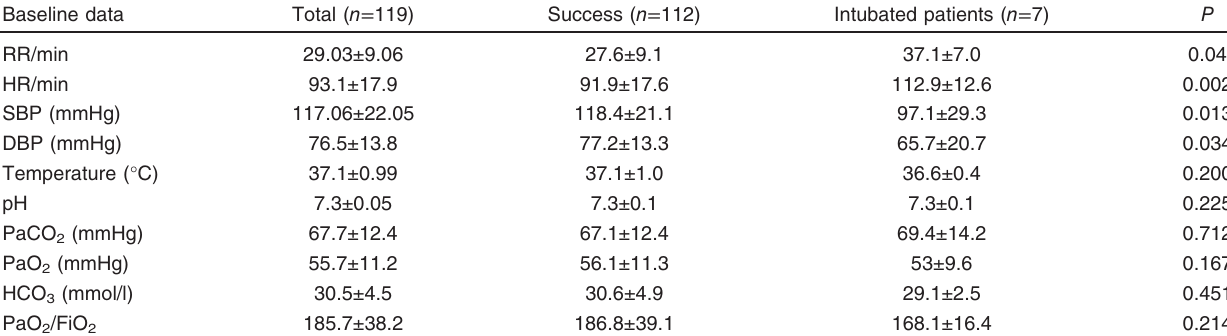
Table 6 Comparisons between the success and failure groups regarding baseline vital signs and arterial blood gas Baseline data